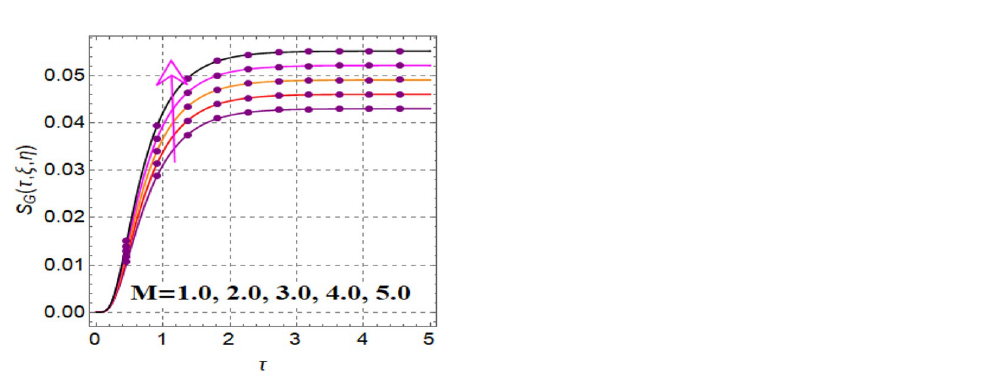
Figure 12. S G (τ , ξ , η) via M